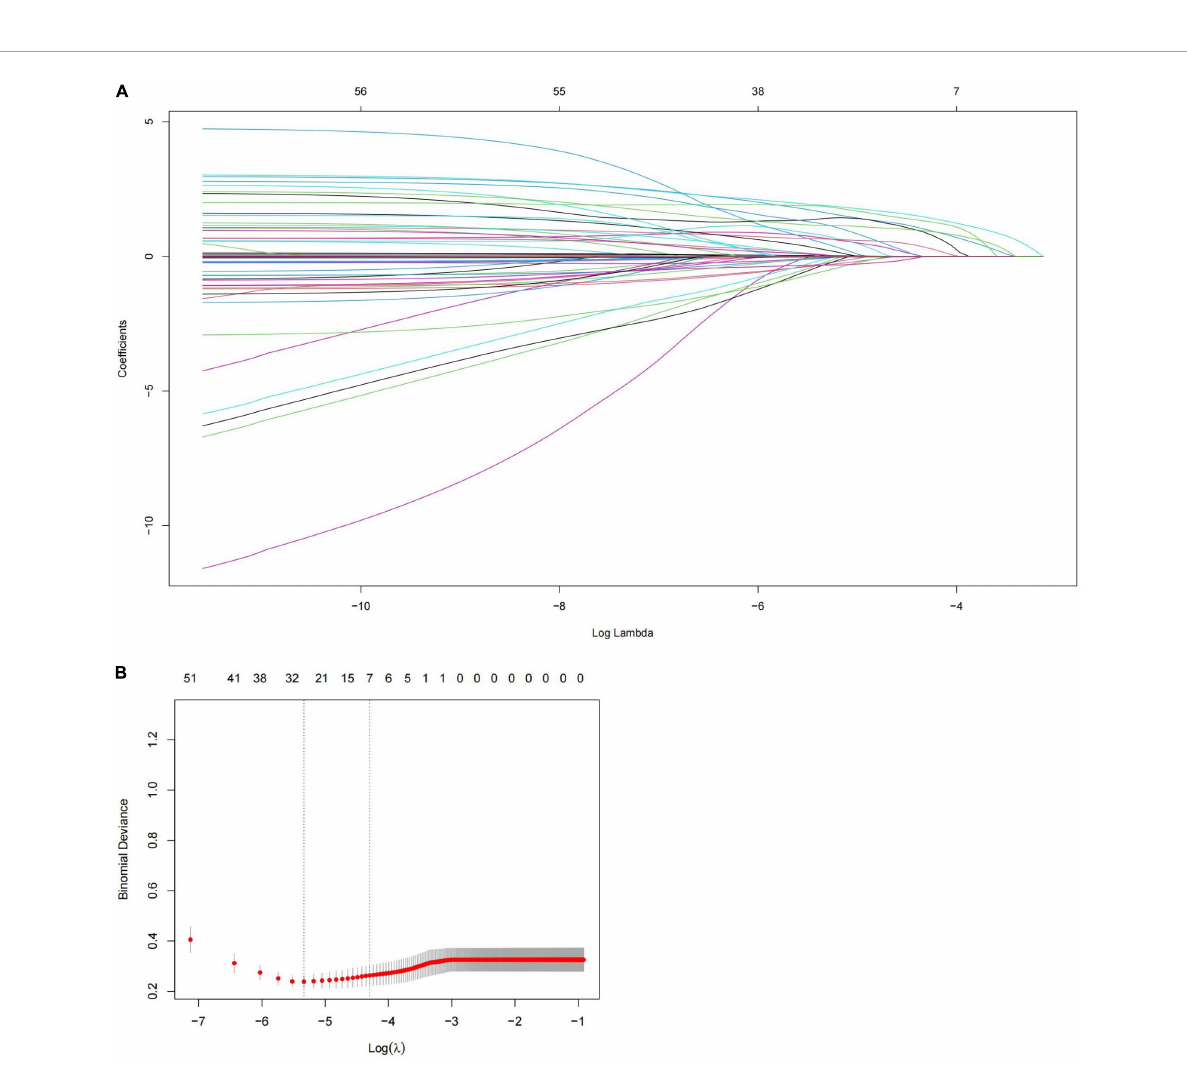
FIGURE2 Predictors selection using LASSO regression. (A) LASSO coefficient profiles of all the clinical features. (B) Identification of the optimal penalization coefficient λ in the LASSO model with 10-fold cross validation and the 1-SE criterion. Results of LASSO regression screening for risk factors for in-hospital mortality. SE, standard error; LASSO, least absolute shrinkage and selection